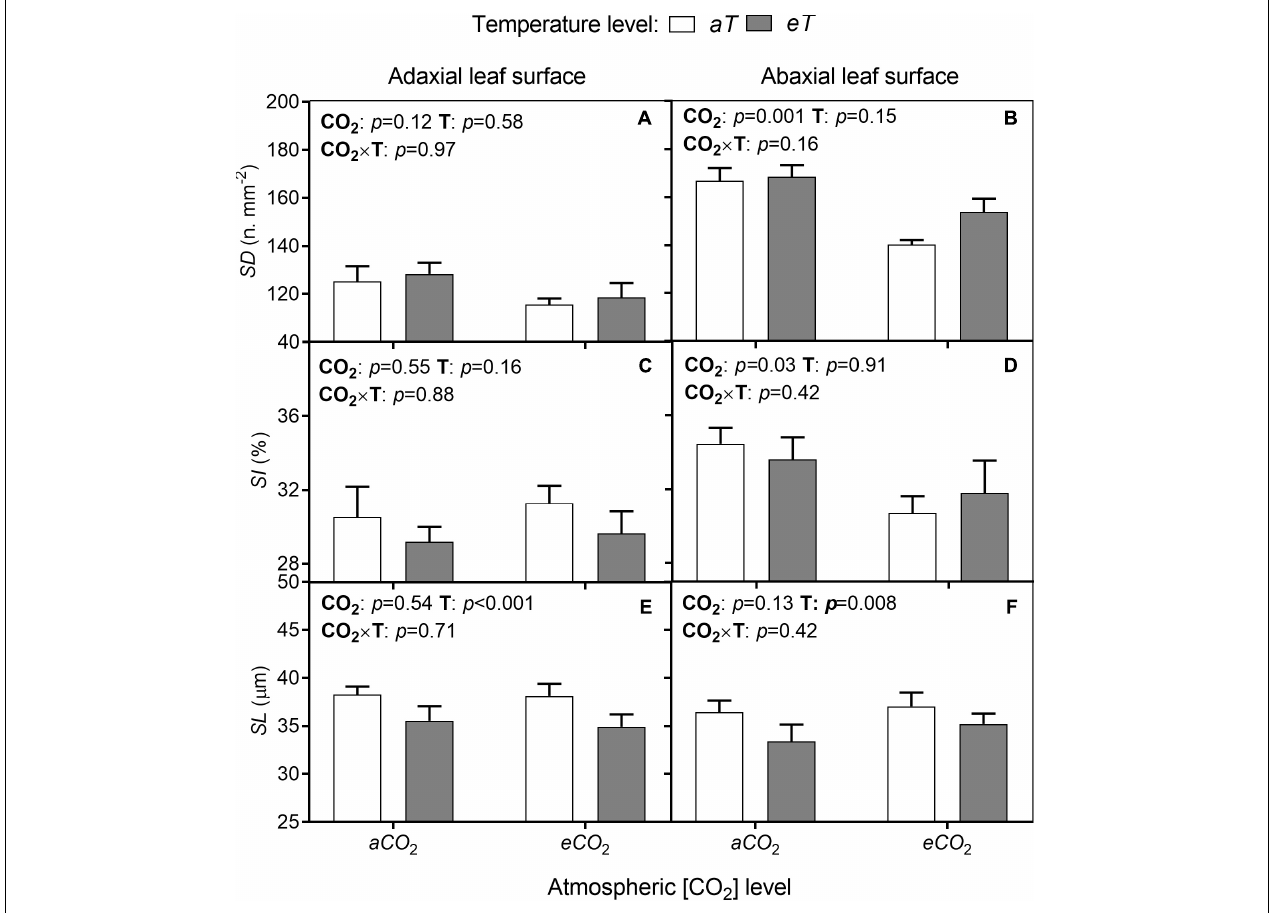
FIGURE 4 | (A,B) Stomatal density ( SD ). (C,D) Stomatal index ( SI ). (E,F) Stomatal length ( SL ) on adaxial leaf surface (left column) and abaxial leaf surface (right column) from leaves of S. capitata grown under different levels of [CO 2 ] and temperature at 66th day of experiment. [CO 2 ] levels: ambient ( aCO 2 ) and elevated ( eCO 2 , 600 µ mol mol − 1 ). Temperature levels: ambient ( aT ) and elevated ( eT , +2 ◦ C above ambient canopy temperature). ANOVA p -values are shown for main effects (CO 2 or T) or interactions CO 2 × T. Stack bars indicate the standard